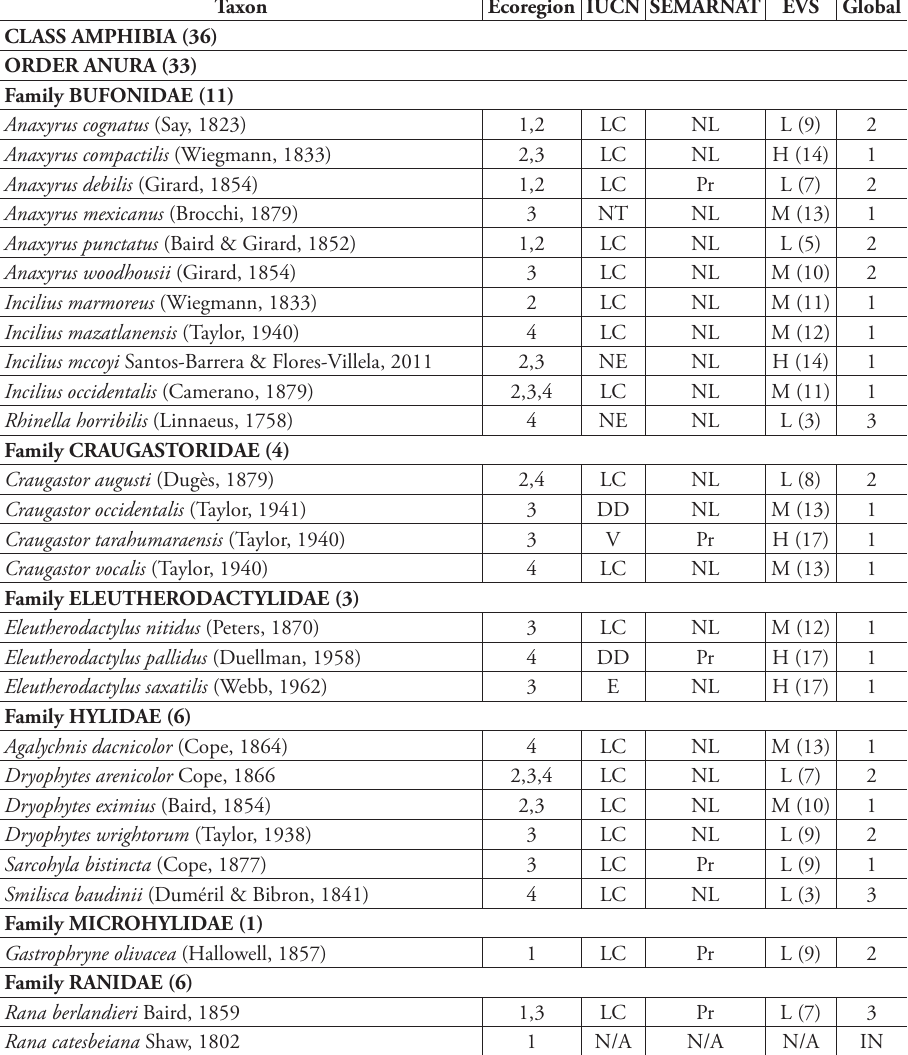
Table 1. Ecoregion (1 = Arid-semiarid; 2 = Valleys; 3 = Sierra; 4 = Quebradas); IUCN Status (DD = Data Deficient; LC = Least Concern, V = Vulnerable, NT = Neat Threatened; E = Endangered; CE = Critically Endangered; NE = not Evaluated) according to the IUCN Red List (The IUCN Red List of Threatened Spe cies, Version 2017-2; www.iucnredlist.org; accessed 9 November 2017), conservation status in Mexico according to SEMARNAT (2010) (P = in danger of extinction, A = threatened; Pr = subject to special pro- tection, NL – not listed), and Environmental Vulnerability Score (EVS – the higher the score the greater the vulnerability: low (L) vulnerability species (EVS of 3–9); medium (M) vulnerability species (EVS of 10–13); and high (H) vulnerability species (EVS of 14–20) from Wilson et al. (2013a,b) and Johnson et al. (2015). Global Distribution: 0 = Endemic to Durango; 1 = Endemic to Mexico; 2 = Shared between the US and Mexico; 3 = widely distributed from Canada or the US to Central or South America; 4 = widely distributed from Mexico to Central America; IN =